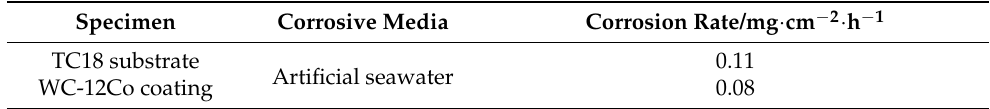
Table 9. The corrosion test results in artificial seawater.